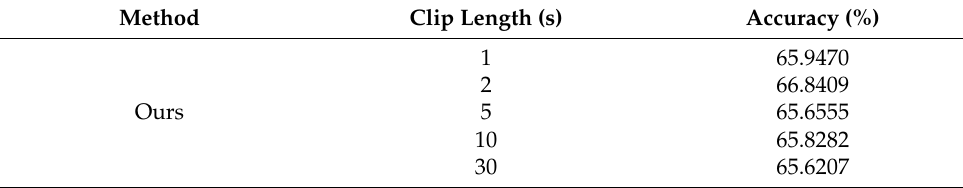
Table 8. Effect of clip length on the performance.